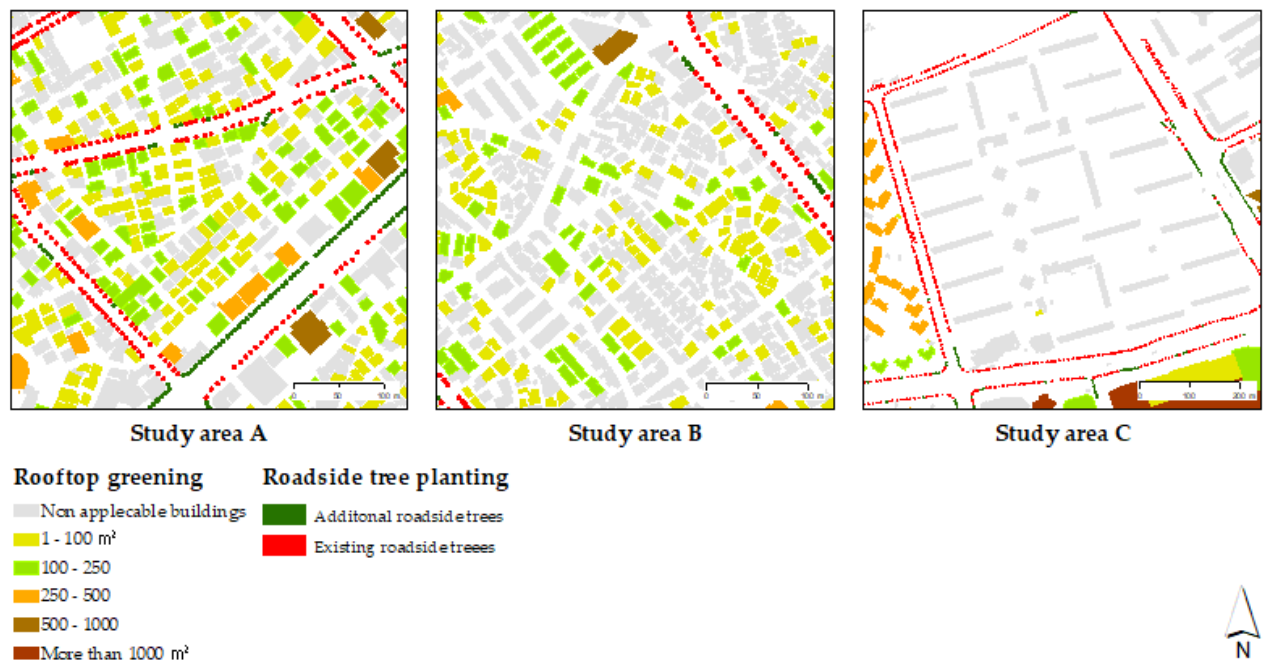
Figure 8. Analysis results of locations suitable for roadside tree planting in case study areas A, B and C. Table 4. Suitable areas for rooftop greening and roadside tree planting in study areas A, B, and C. Roadside Tree Total Number of Buildings Green Roof Buildings Roadside Tree Green Roof Buildings Study Area Planting